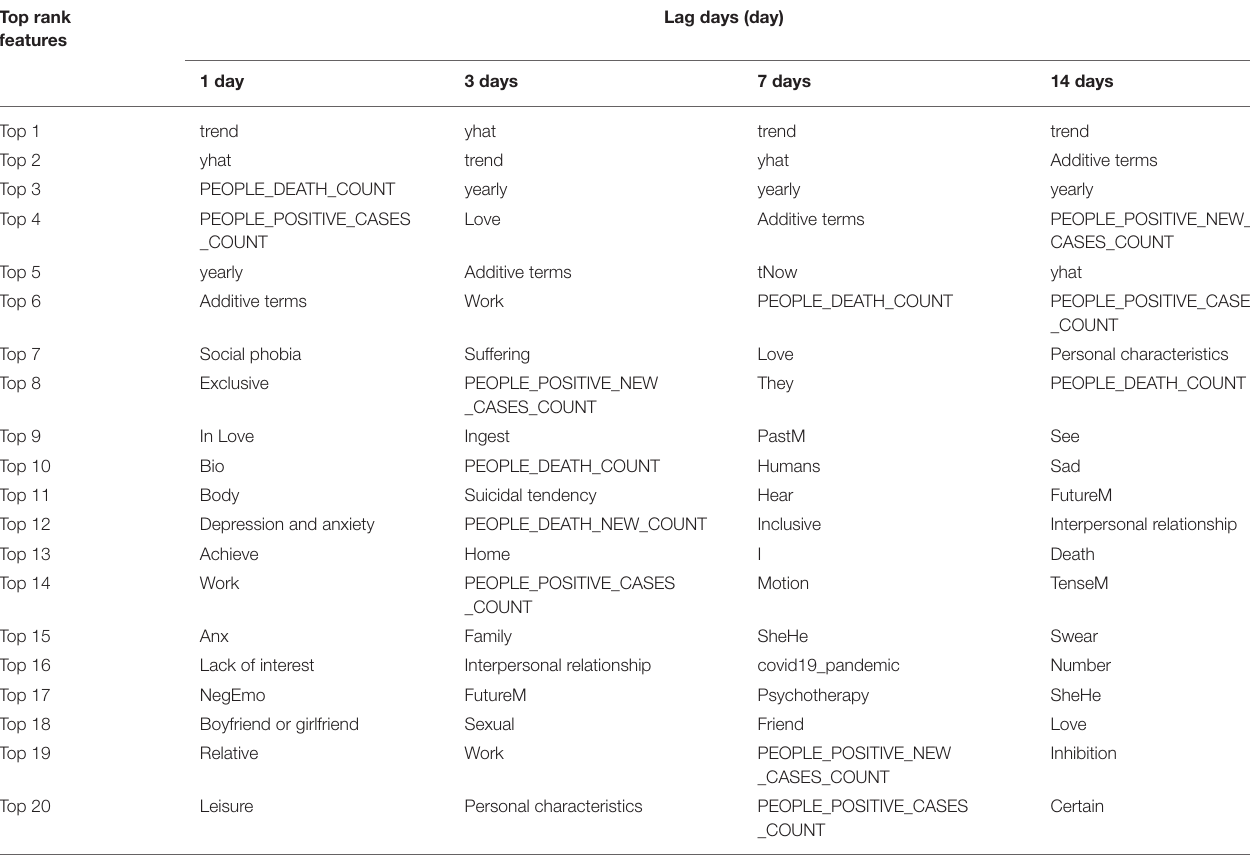
TABLE 6 | Top-20 features in predictions with different lag days. Top rank